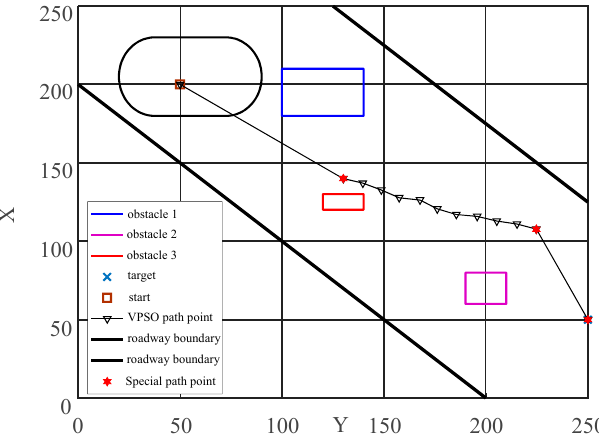
Figure 13. Simulation of the rectification points searching and tracking